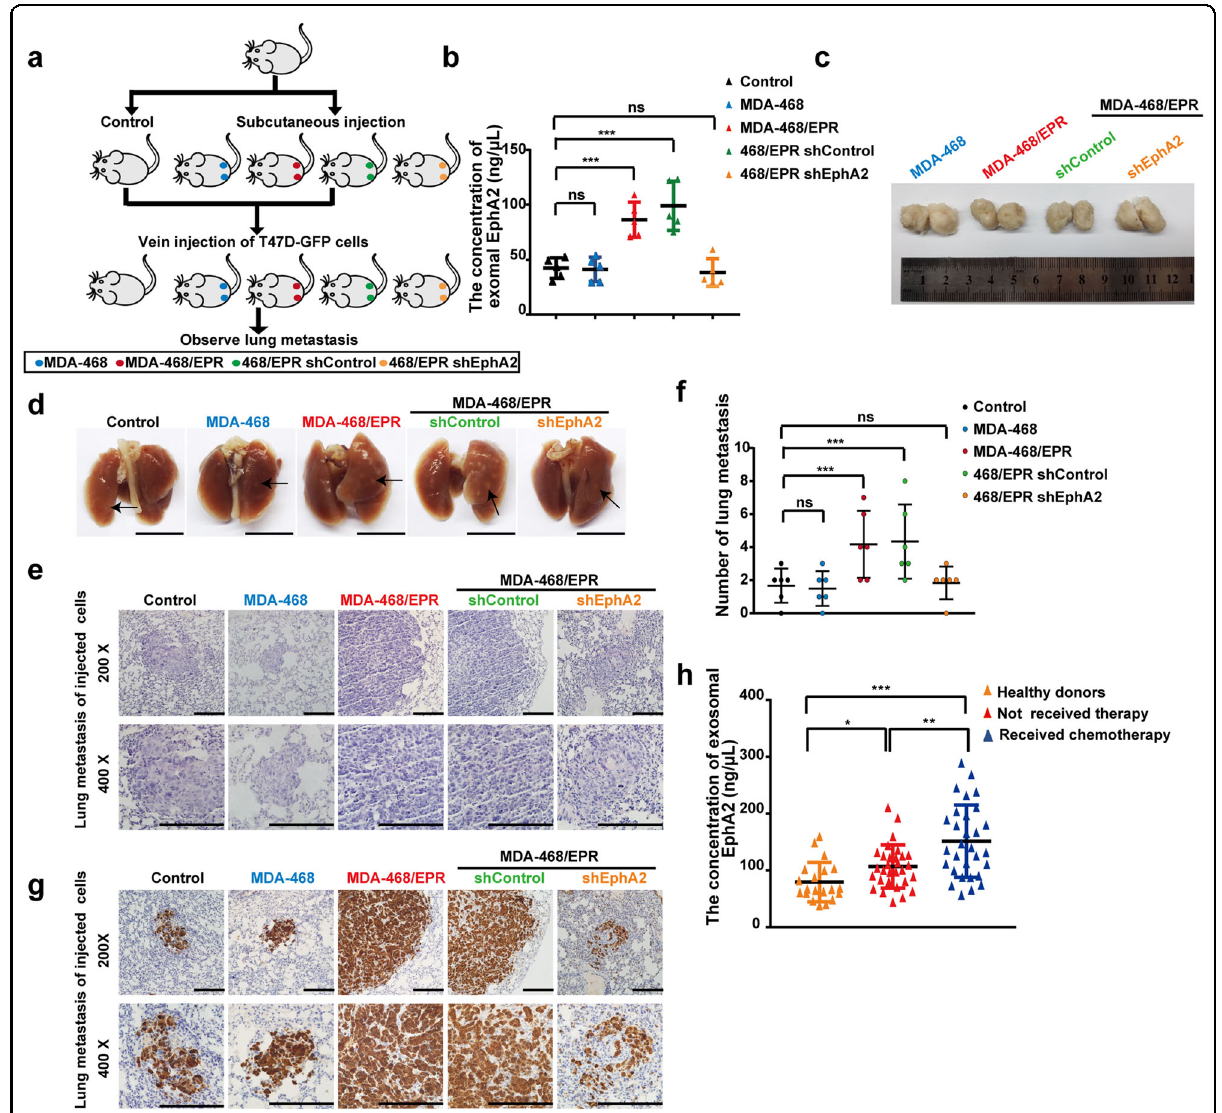
Fig. 7 Exosomal EphA2 promotes breast cancer cell metastasis in vivo. a Schematic diagram of the in vivo experimental design. b Exosomal EphA2 protein was signi fi cantly upregulated in plasma from the MDA-MD-468/EPR and MDA-MD-468/EPR-sh control groups compared with the MDA-MD-468 and MDA-MD-468/EPR-EphA2-KD groups. *** P < 0.001 and ns P > 0.05 indicate no statistical signi fi cance. c Representative images of subcutaneous tumor formed in mice. d The drug-resistant cell inoculated group showed more metastatic foci on the mice lung surface than that in the drug-sensitive cell inoculated group. Scale bars: 1 cm. e, f H & E staining showed that the number of tumor metastatic foci in the lung tissue was signi fi cantly higher in the drug-resistant cell inoculated group than in the drug-sensitive cell inoculated group. Data are shown as mean ± SD. Statistical analysis was performed by one-way ANOVA. *** P < 0.001 and ns P > 0.05 indicate no statistical signi fi cance. Scale bars: 200 μ m. g The metastatic foci in the lungs of mice were investigated using immunohistochemical (IHC) staining with anti-GFP antibodies. Scale bars: 200 μ m. h ELISA assays showed that the concentration of exosomal EphA2 in plasma was collected from healthy donors ( n = 20), early-stage breast cancer patients without any systemic treatment ( n = 30), and advanced patients received at least one prior line of systemic therapy ( n = 30). Data are shown as mean ± SD. Statistical analysis was performed by one-way ANOVA. * P < 0.05, ** P < 0.01, *** P < 0.001, and ns P > 0.05 indicate no statistical signi fi